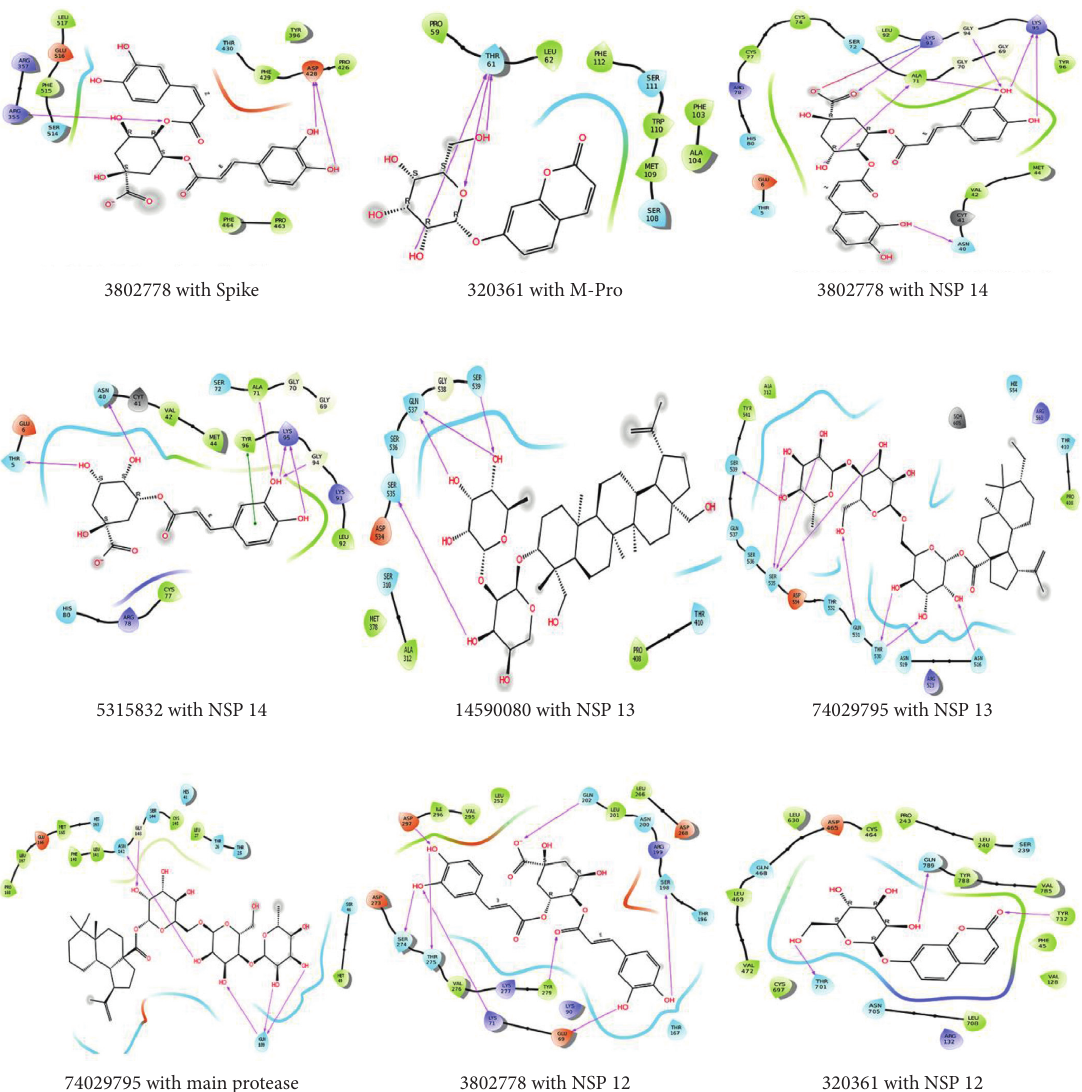
Figure 1: The 2D interaction binding mode of homeopathy compounds with SARS-CoV-2 proteins. The pink color arrow represents the hydrogen bond